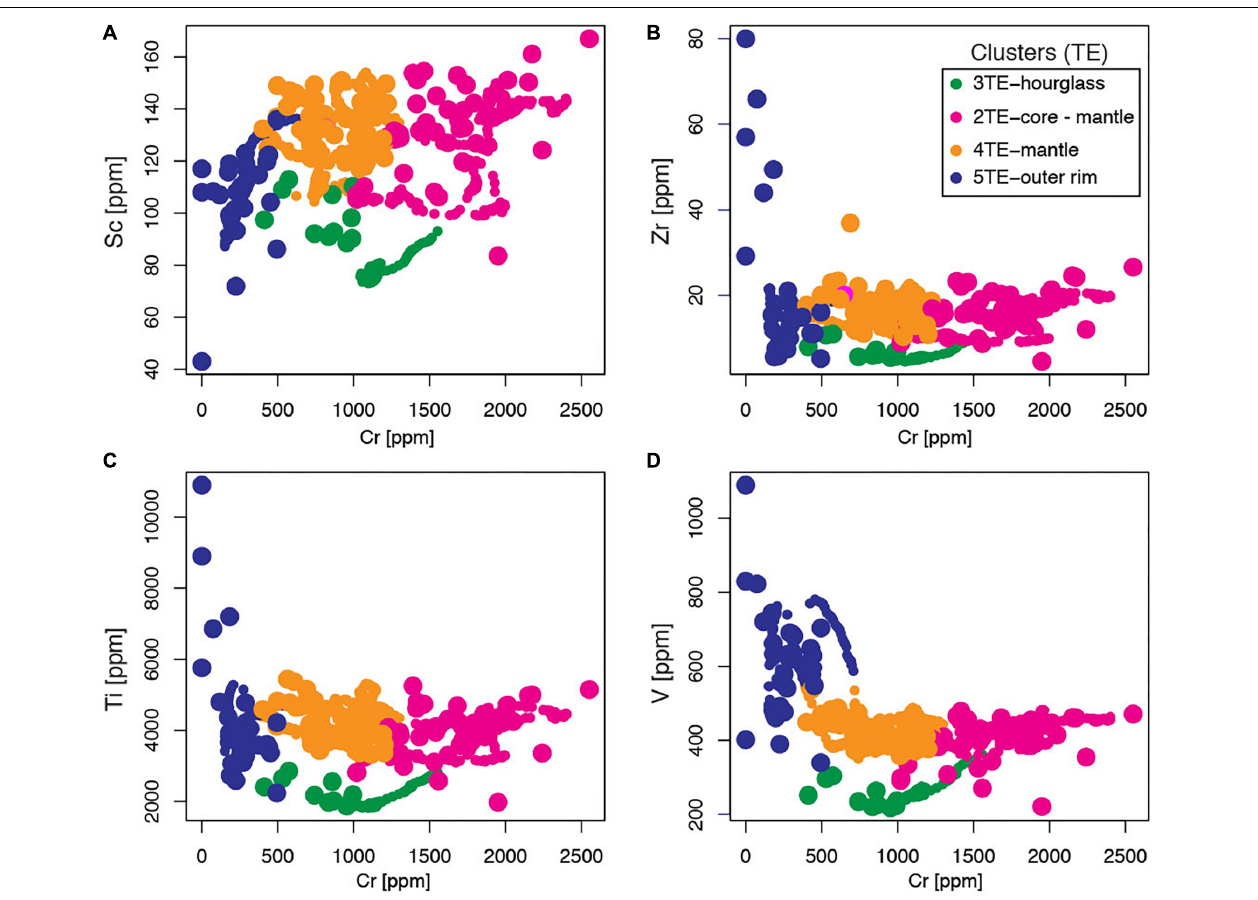
FIGURE 10 | Harker diagrams showing the variation of (A) Sc, (B) Zr, (C) Ti, and (D) V against Cr for LA-ICP-MS spot analyses (large circles) and profiles (small circles). The color coding is the same of Figure 7